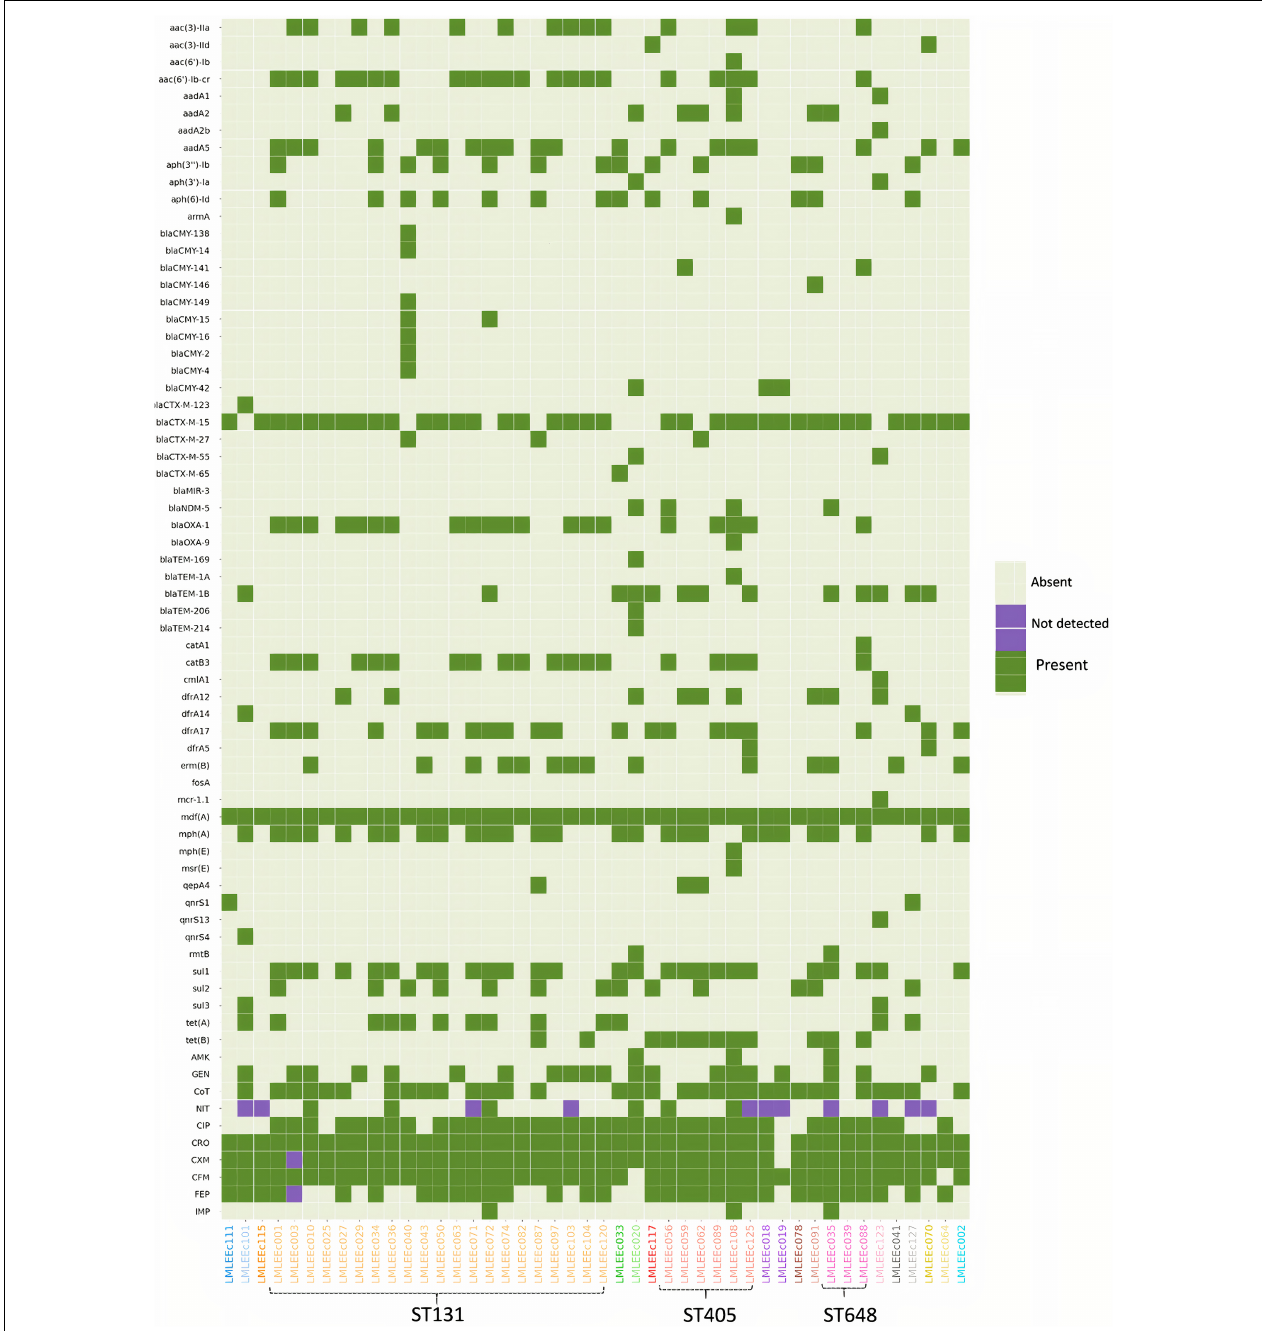
FIGURE 2 | Heatmap showing the distribution of acquired AMR genes and AMR phenotypic profiles within 46 E. coli isolates. Gene names are listed on the left, and strain names are listed below the image. The presence of gene is indicated by colored blocks, and the gene absence is indicated by gray blocks. CRO, ceftriaxone; CXM, cefuroxime; CFM, cefixime; FEP, cefepime; NIT, nitrofurantoin; AMK, amikacin; CIP, ciprofloxacin; CoT, cotrimoxazole; IMP, imipenem; GEN,